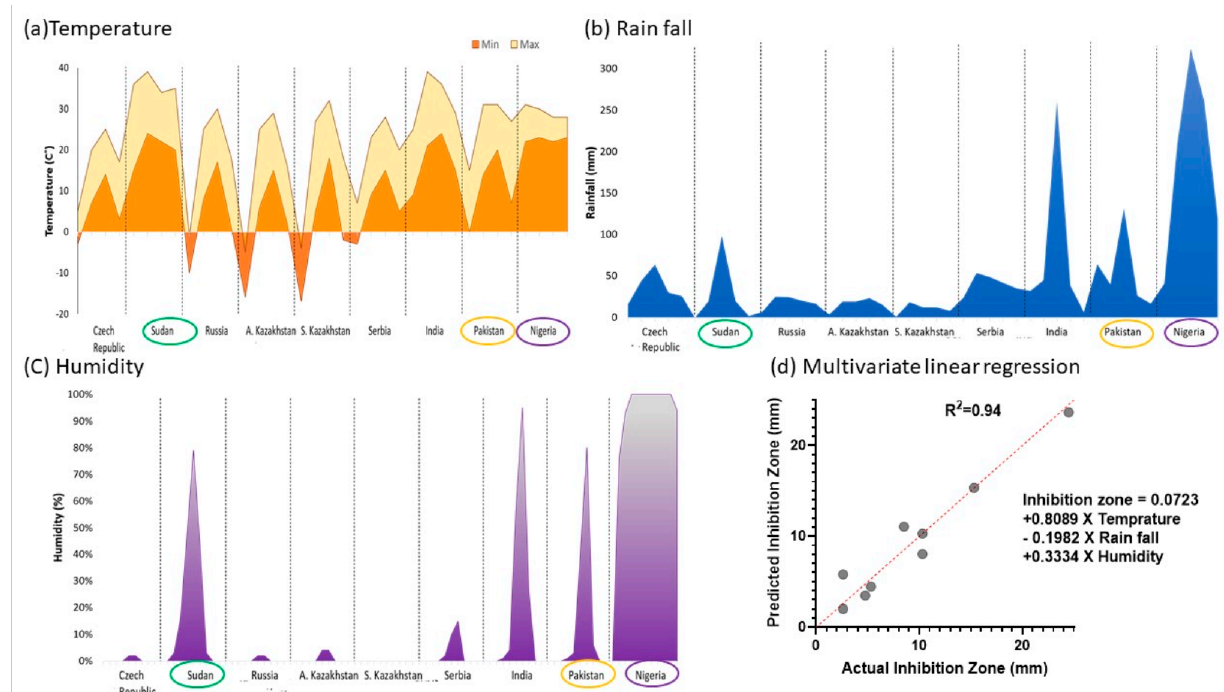
Figure 2. Climate upon inhibition zone. Average yearly ( a ) temperature ( b ), rainfall and ( c ) humidity of origin of hemp plant. Green circle: Highest against Gram-positive bacteria. Yellow circle: Highest against Gram-negative bacteria. Purple circle: Highest against fungi. ( d ) Multivariate linear regression. The Gram-positive bacteria were used in these analysis because HSO showed the most activity against Gram-positive bacteria. Figure 2d shows multivariate linear regression to find the relationship between the ZGI with temperature, rainfall, and humidity. The linear regression showed the climate on prediction of ZGI (R2 = 0.94). The prediction equation: Inhibition zone = 0.0723 + 0.8089 × Temperature − 0.1982 × Rainfall + 0.3334 × Humidity. Temperature is the strongest predictor ( p < 0.01) followed by humidity and rainfall ( p <